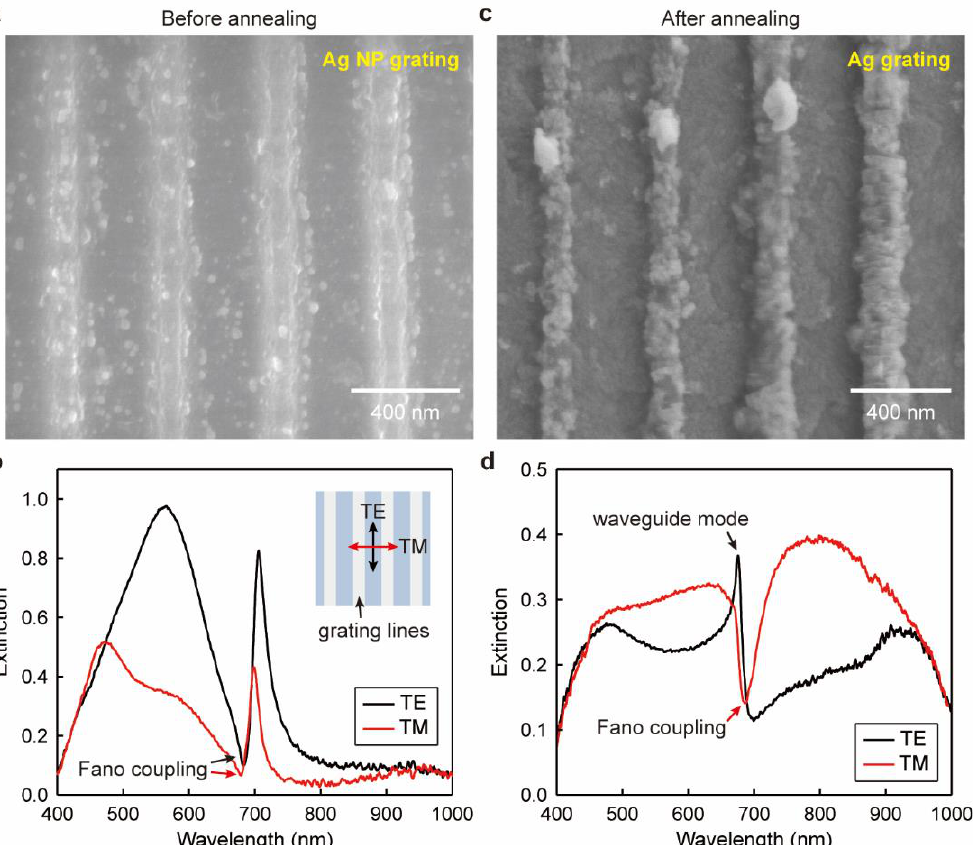
Figure 2. Ag NP grating slab structure modified by high-temperature annealing. ( a ) SEM image of the Ag NP grating and ( b ) the corresponding extinction spectra measured under the TE and TM polarizations. Inset: geometry of the optical measurement. ( c ) SEM image of the Ag grating and ( d ) the TE and TM extinction spectra.